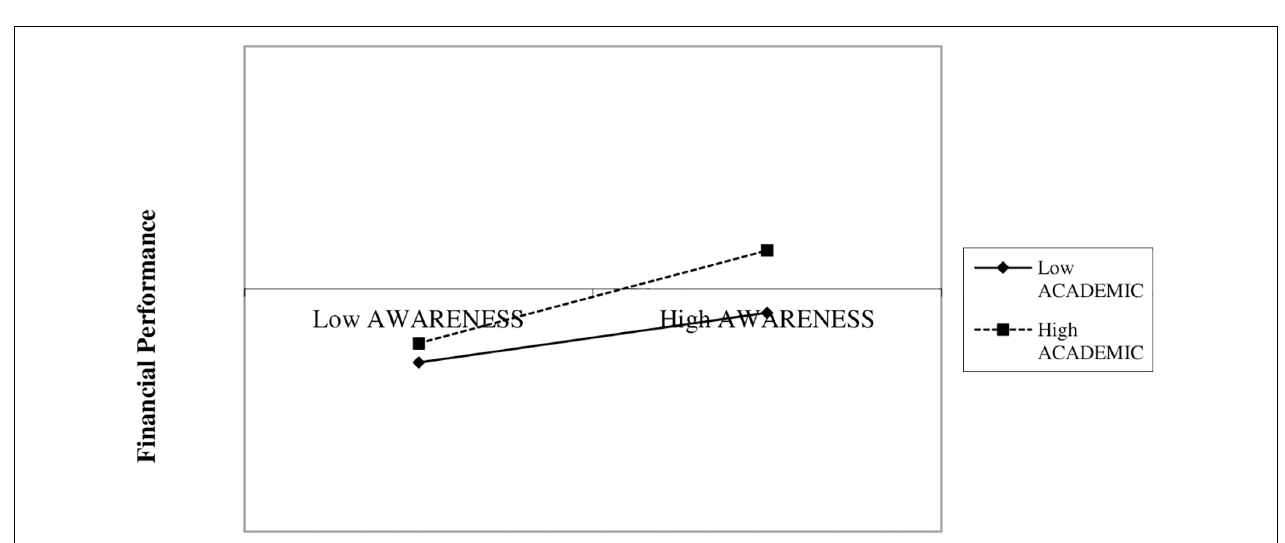
FIGURE 3 | Two-way interaction. SMM * ACADEMIC. SSM, social media marketing, how intensely the company implements Social Media Marketing actions; ACADEMIC, academic background of the female entrepreneur.